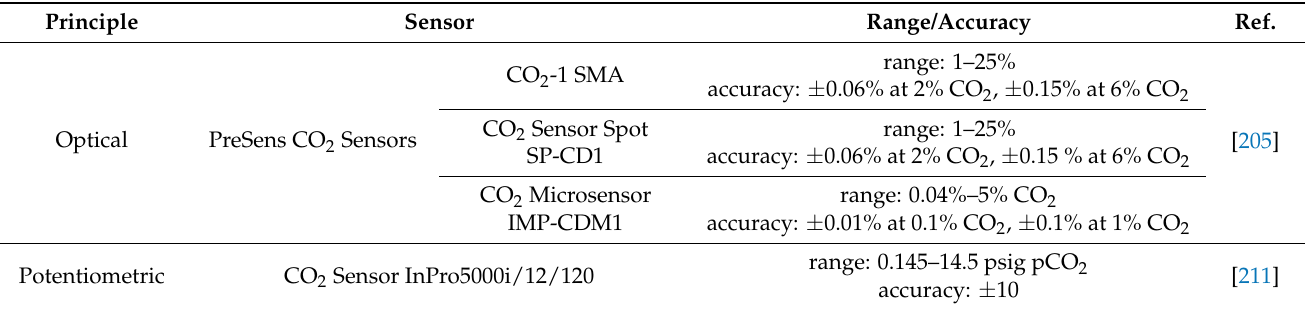
Table 5. Commercially available CO 2